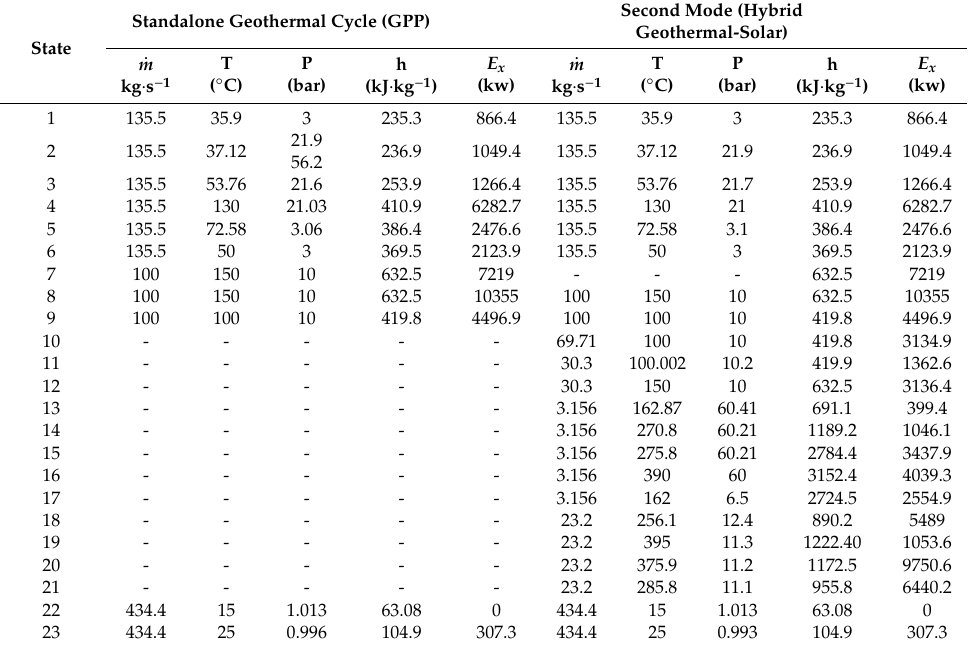
Table 8. Flow information of first and second modes of